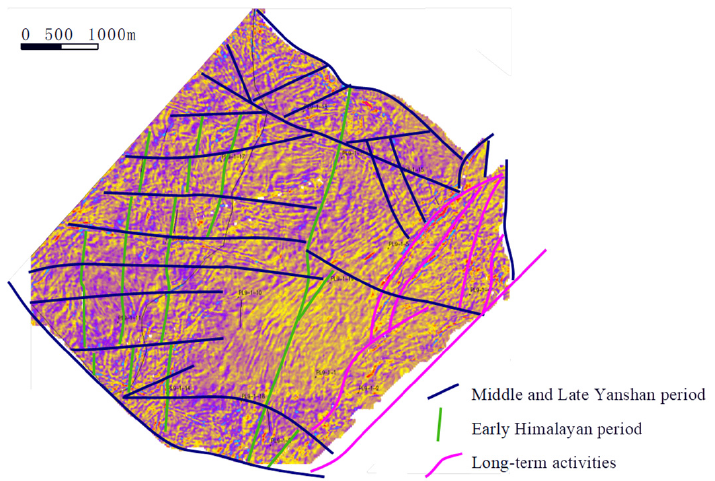
Figure 9. Distribution of deep fault system in PL buried-hill. The fault was interpreted according to 3D root mean square amplitude attribute. It is a time slice map.